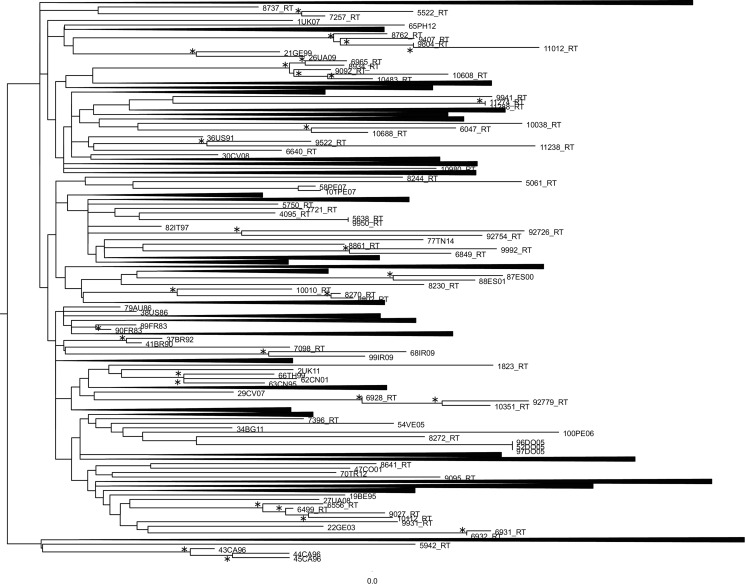
Phylogenetic relationship of the HIV-1 subtype-B sequences with the subtype-B reference sequences downloaded from the NCBI sequence database (https://www.ncbi.nlm.nih.gov/). The asterisk along a branch represents significant statistical support for the clade subtending that branch (bootstrap support 70%). The collapsed cluster in the figure were what not statistically significant.